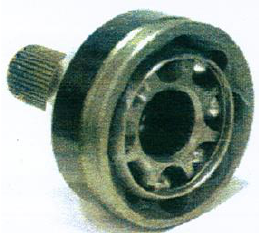
Figure 7. Picture of a bowl-balls joint.